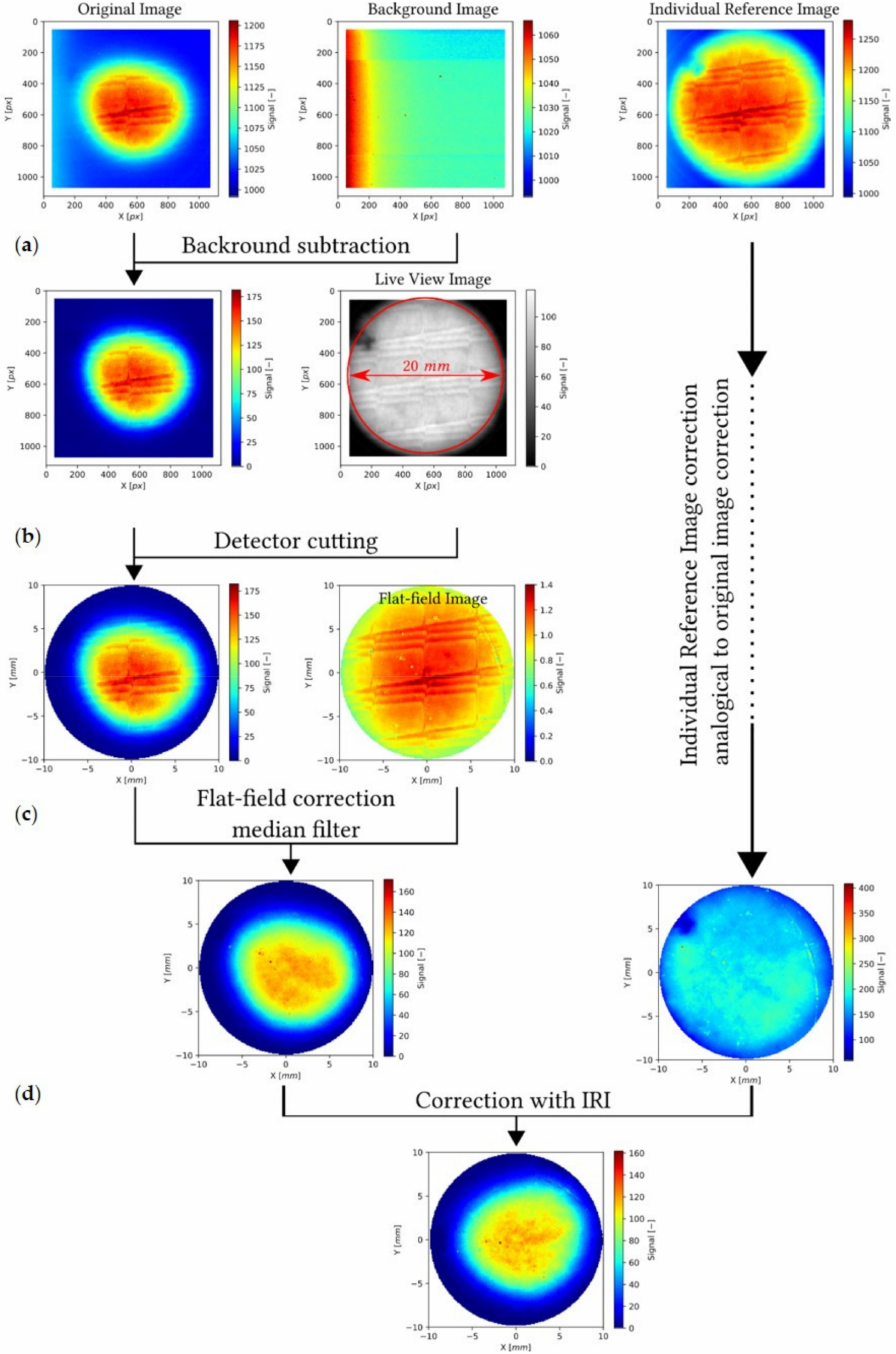
Figure 9. ( a ) Image correction procedure, consisting of background subtraction; ( b ) Cutting based on the circular foil found in a live view image; ( c ) flat-field correction and median filtering. The image of individual pixel response, i.e., readout of the same foil after exposure to uniform radiation field is corrected in the same procedure; ( d ) Afterwards, the corrected measurement image is corrected with the individual reference